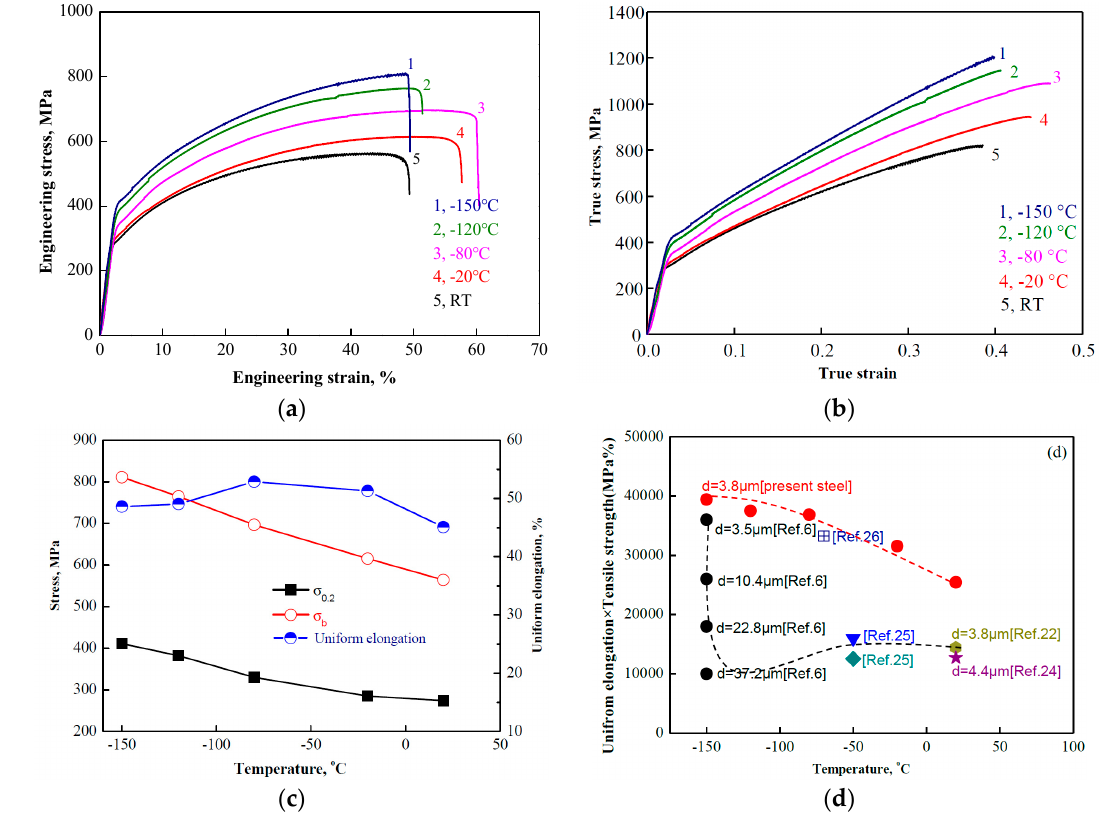
Figure 2. Stress-strain curves of investigated steel, tested at various temperatures. ( a ) Engineering stress-engineering strain; ( b ) True stress-true strain; ( c ) Temperature dependence of tensile properties; ( d ) temperature and PSE (the product of ultimate tensile strength and uniform elongation) relationship.